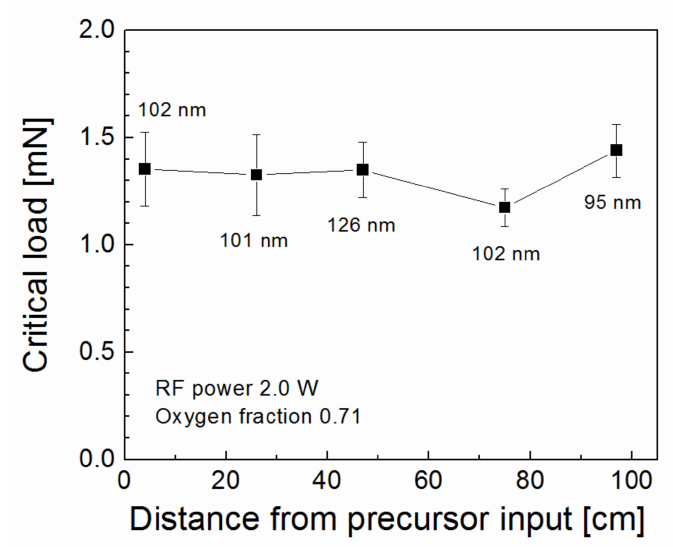
Figure 5. Critical load corresponding to plasma nanocoatings on silicon wafers distributed along the tubular reactor for selected deposition conditions. Nanocoating thickness is